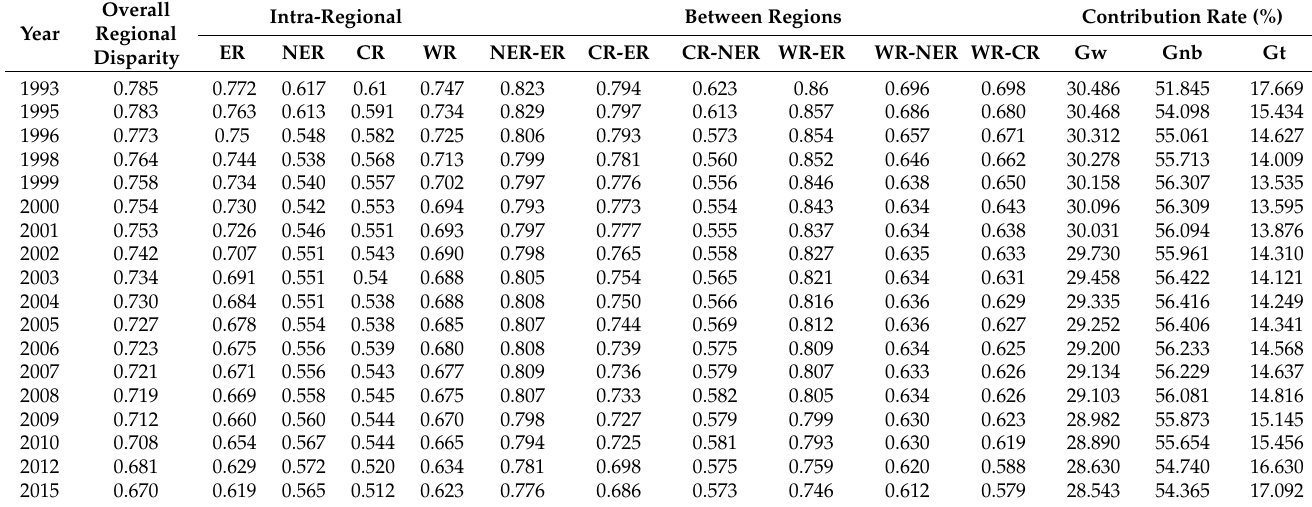
Figure 7. The Dagum Gini coefficients of USS and USE. Note: USS is the urban spatial expansion and USE is the urban socioeconomic expansion. Table 1. DG coefficient and its decomposition of the USS.